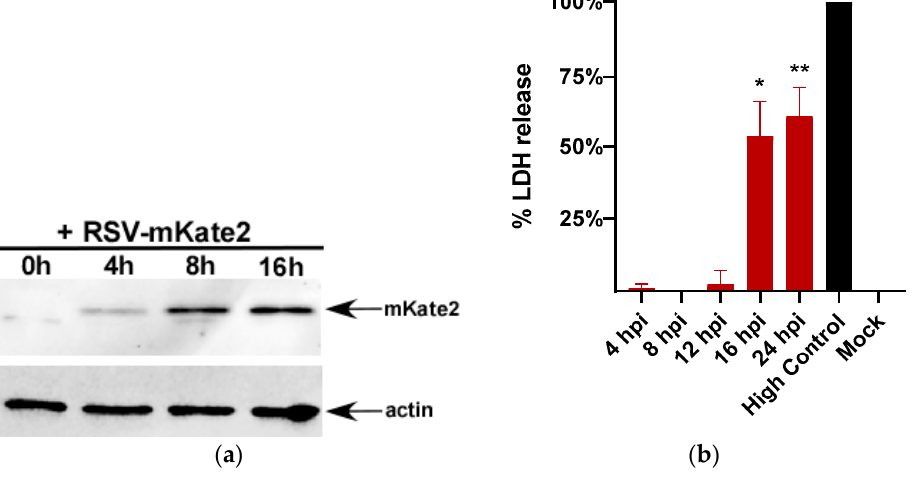
Figure 1. Lactate dehydrogenase (LDH) release during respiratory syncytial virus (RSV) infection of the human monocyte cell line (THP-1) macrophages. ( a ) THP-1 macrophages infected with RSV-mKate2 (MOI = 2) for 0 h–16 h were subjected to Western blotting with anti-RFP antibody. Western blot data shown is representative of three independent experiments with similar results. ( b ) THP-1 macrophages were infected with RSV (MOI = 1) and LDH release was measured at 4 h, 8 h, 12 h, 16 h, and 24 h post infection ( n = 16 technical replicates from two independent experiments). % LDH release was calculated by using high control (cell lysate) value as 100% LDH release. * p and ** p ≤ 0.05 compared to mock using a Student’s t -test.